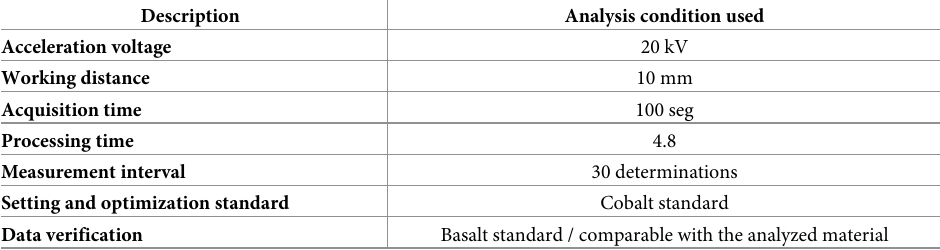
Table 3. Analytical conditions used for EDS-SEM measurements.